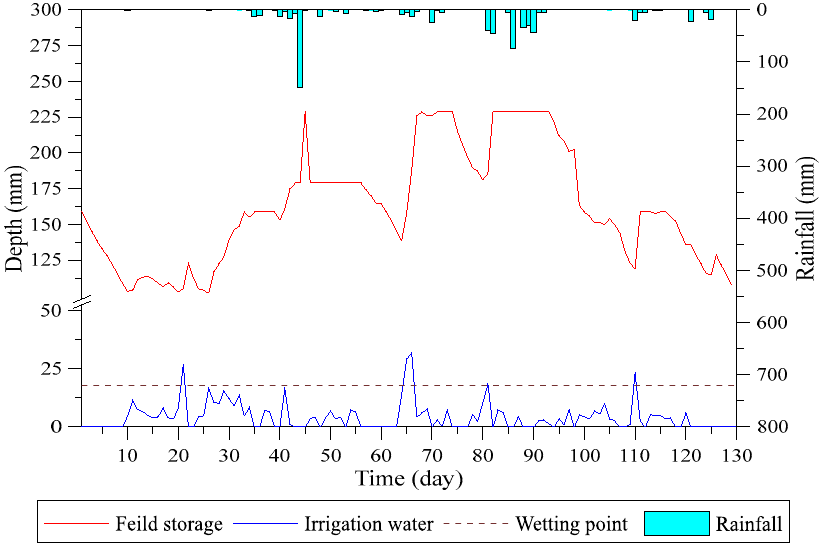
Figure 23. Simulation of block 3 under 50% reduction of planned irrigation water during first crop season.